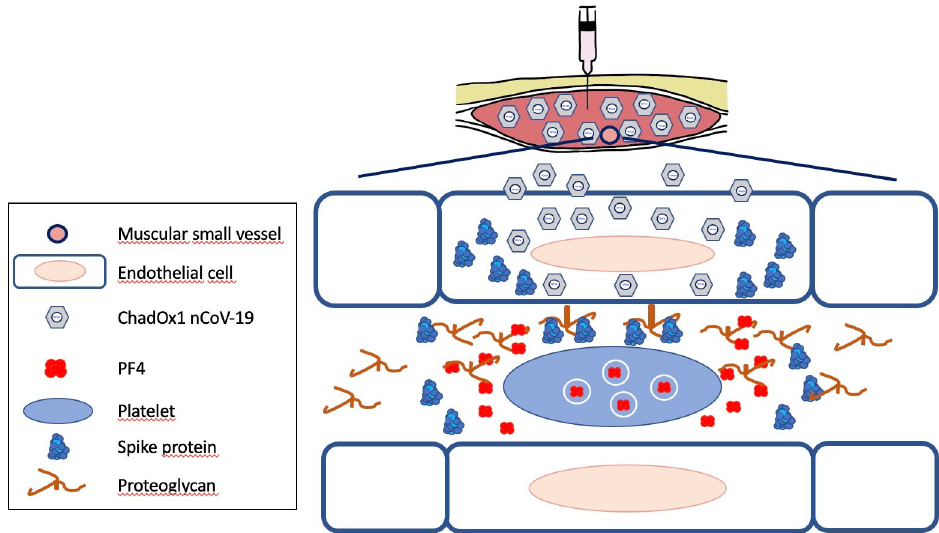
Fig 2. Hypothetical model for thrombotic thrombocytopenia after adenoviral vector-based COVID-19 vaccines. After intramuscular injection, vaccine adenoviruses infect endothelial cells, inducing their production of the SARS-CoV-2 Spike protein. Heparan sulfate PG could bind the spike protein on the luminal side of endothelial cells or be released by damaged cells. Spike proteins would activate platelets via ACE2-dependent and ACE2-independent mechanisms. PF4 released by activated platelets would become immunogenic after binding heparan sulfate PG shed from endothelial cells. ACE2, angiotensin converting enzyme 2; COVID-19, Coronavirus Disease 2019; PF4, platelet factor 4; PG, proteoglycan; SARS-CoV-2, Severe Acute Respiratory Syndrome Coronavirus 2.